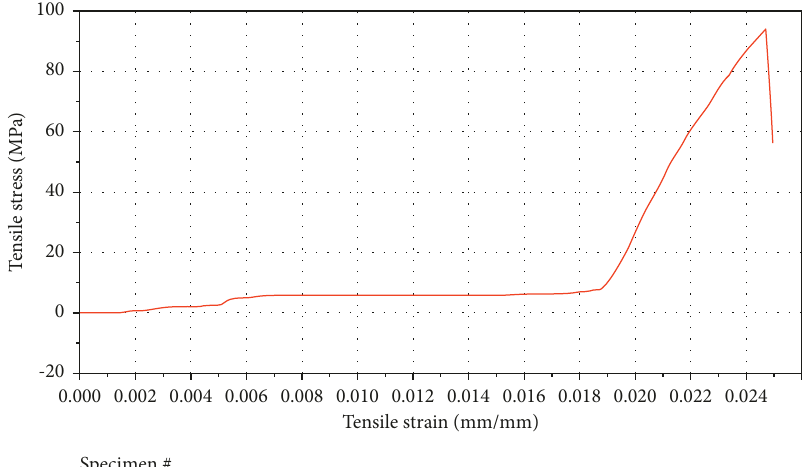
Figure 8: Tensile strength of the unreinforced AA6061